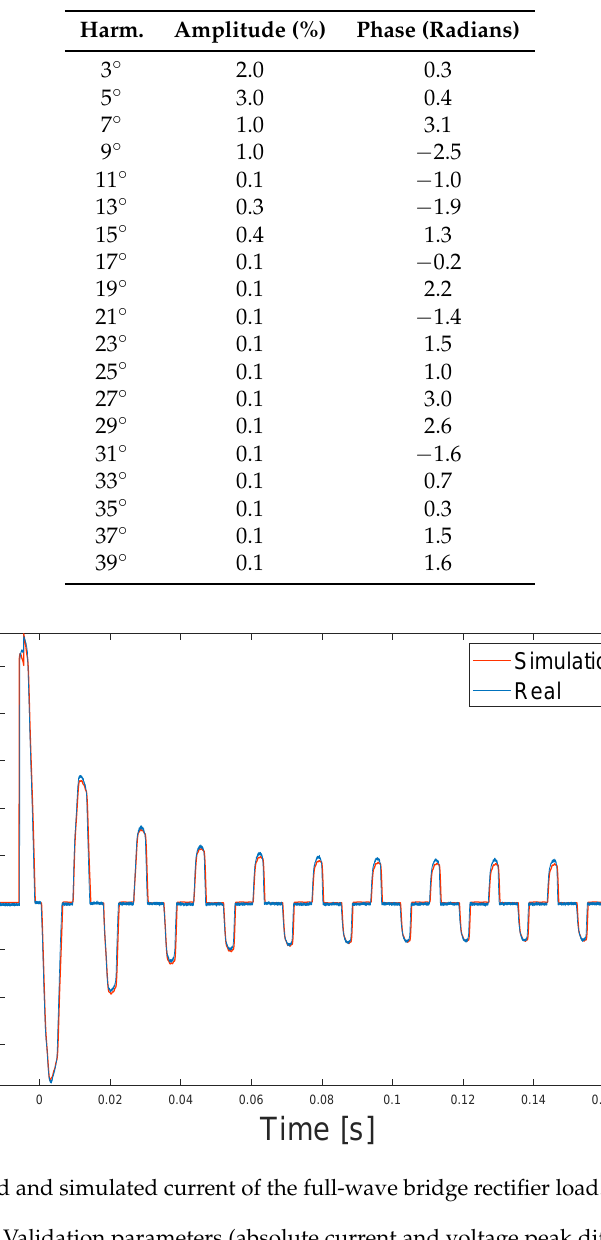
Table 12. Measurement of voltage and phase of harmonics in the power network.